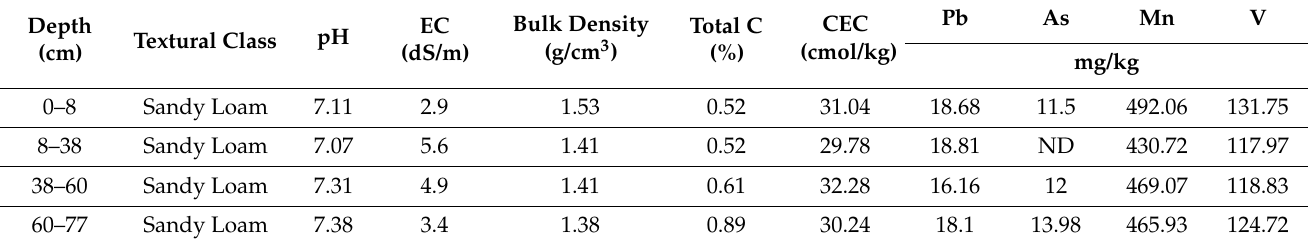
Table 1. Soil properties found in the stormwater park site.